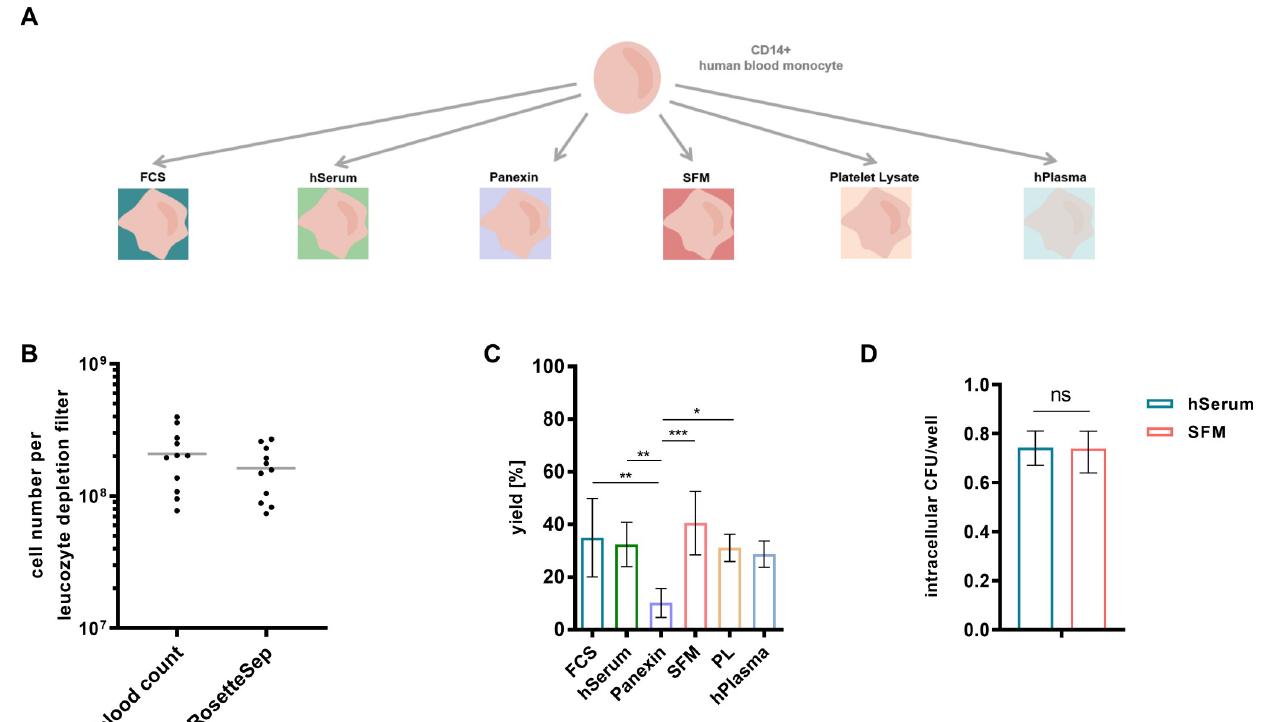
Fig 1. Different hMDM cultivation strategies do not affect intracellular survival. (A) After enrichment, monocytes were cultivated in FCS, hSerum, Panexin, SFM, PL or hPlasma as illustrated. (B) Human monocytes were obtained from leukocyte depletion chambers by negative selection using the RosetteSep kit. Shown are absolute monocyte numbers before (blood count) and after purification (RosetteSep) of 11 independent measurements (mean). (C) Human monocytes were differentiated into hMDMs using different serum components. Yield in % from initially seeded cells. Data are depicted as median and interquartile range (n � 4 independent experiments with different donors). Significant differences between data sets are marked by asterisks ( � p < 0.05, �� p < 0.01, ��� p < 0.001). (D) hMDMs were infected with B . pseudomallei at an MOI of 300. Shown is the ratio of intracellular CFU/well at 3h compared to time point 0h of 3 independent experiments with different donors, performed in technical triplicates (median and interquartile range). FCS (Fetal Calf Serum), hSerum (human Serum), SFM (Serum Free Medium), PL (Platelet Lysate), hPlasma (human Plasma), hours (h), ns (not significant).